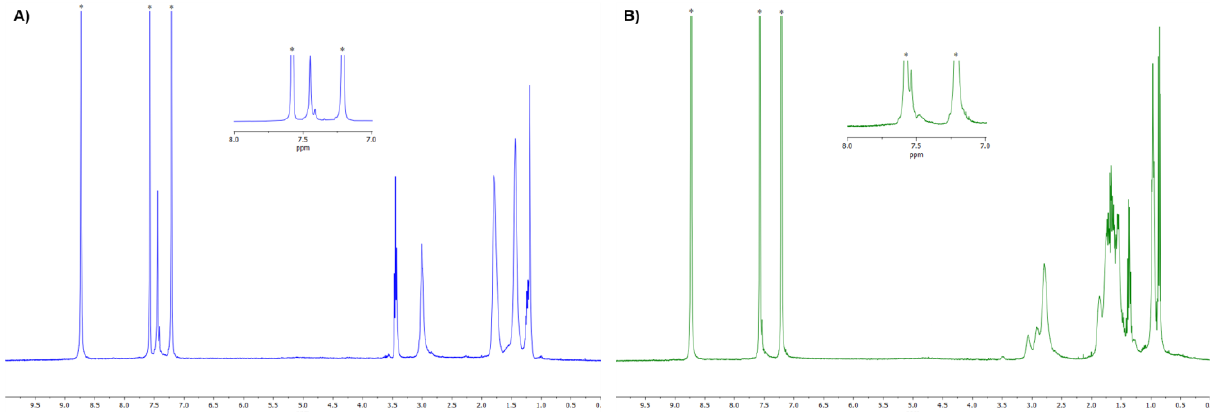
Figure 2. 1 H-NMR spectra of double-cable copolymers, P[(T6Br)- co -(T6F)] (blue line), ( A ) and P[(T6buP + )- co -(T6F)] (green line), ( B ). Asterisk: solvent resonance pyridine-d 5 . Inset: expansion of the aromatic region.